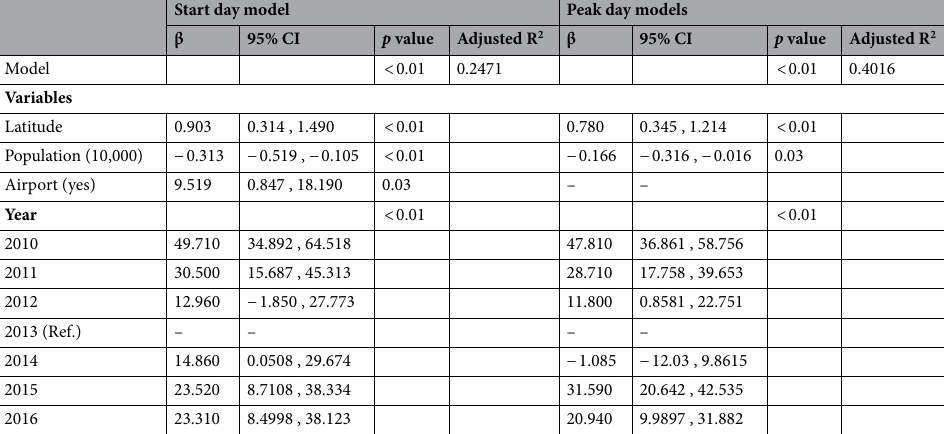
Table 2. Selected multivariate models for ILI start day and peak